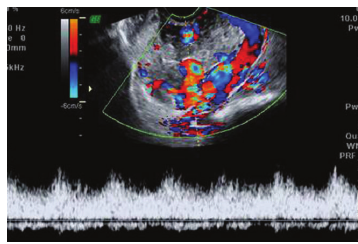
Figure 4: Color flow Doppler of the same patient as in Figure 3(d) reveals a mosaic pattern of color signal within the cystic spaces representing turbulent flow. Spectral analysis of the abnormal vasculature reveals high velocity low impedance pulsatile